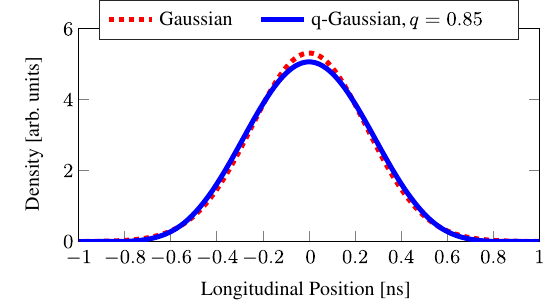
FIG. 5. Longitudinal q-Gaussian profile used in the simula- tions, compared to a Gaussian profile of the same rms